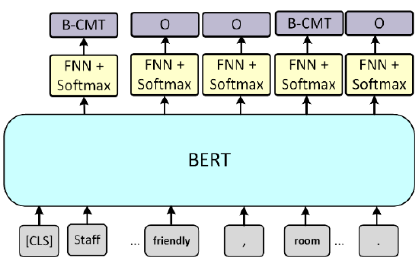
Figure 3. Comment boundary detection model.